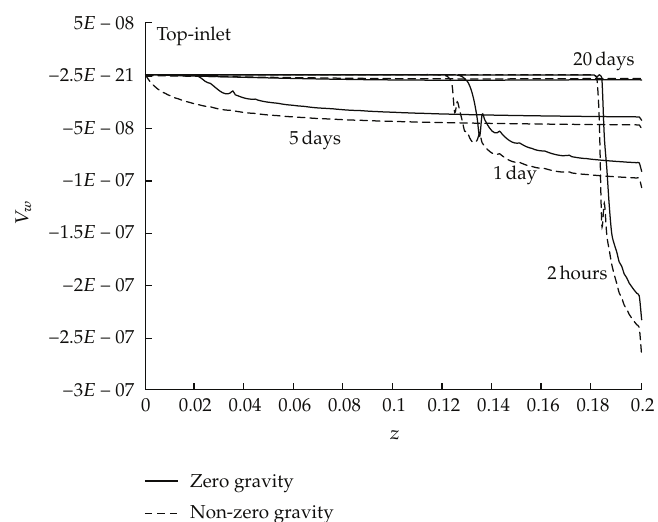
Figure 12: Comparison between considering and neglecting gravity e ff ect on water z -velocity for the top- inlet case, at x (cid:8) 0 . 1m